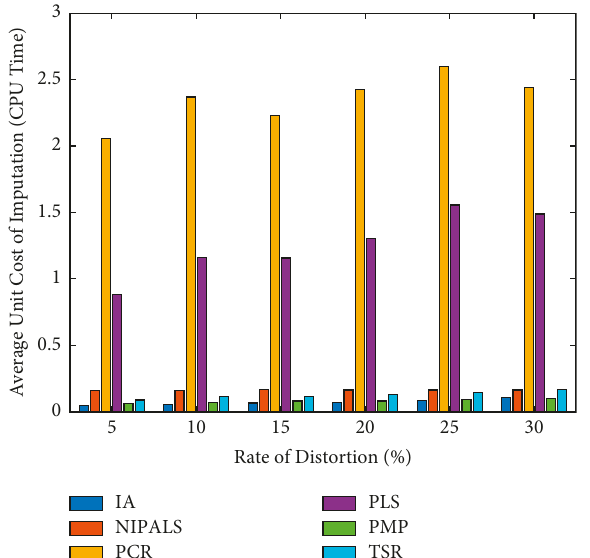
Figure 6: Cost of imputation